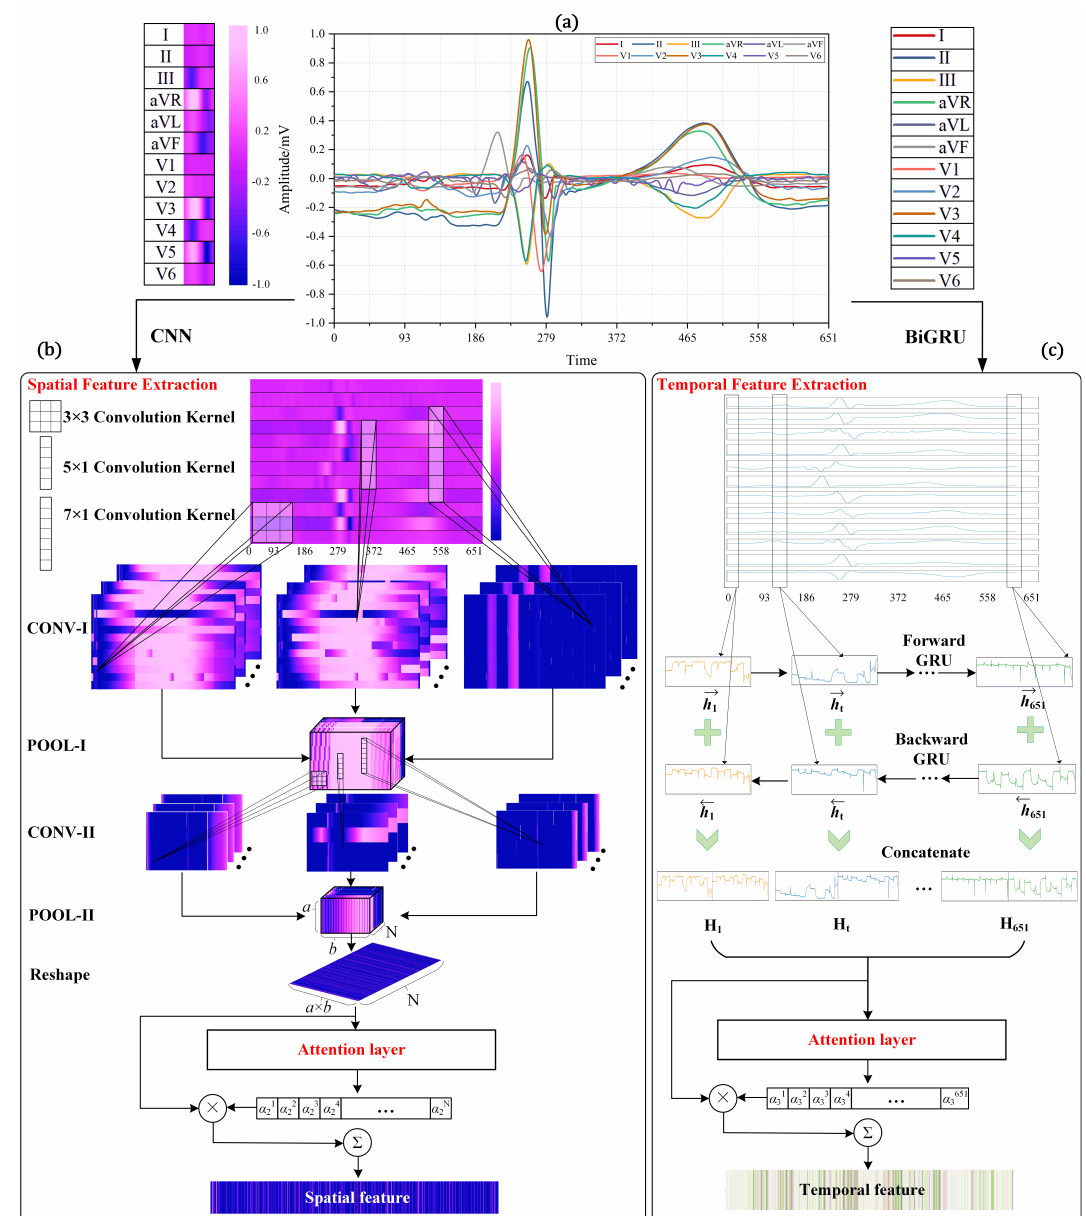
Figure 3. Feature extraction process after lead selection: ( a ) 12-lead heartbeat signal after lead selection; ( b ) spatial feature extraction process by CNN module; and ( c ) temporal feature extraction process by BiGRU